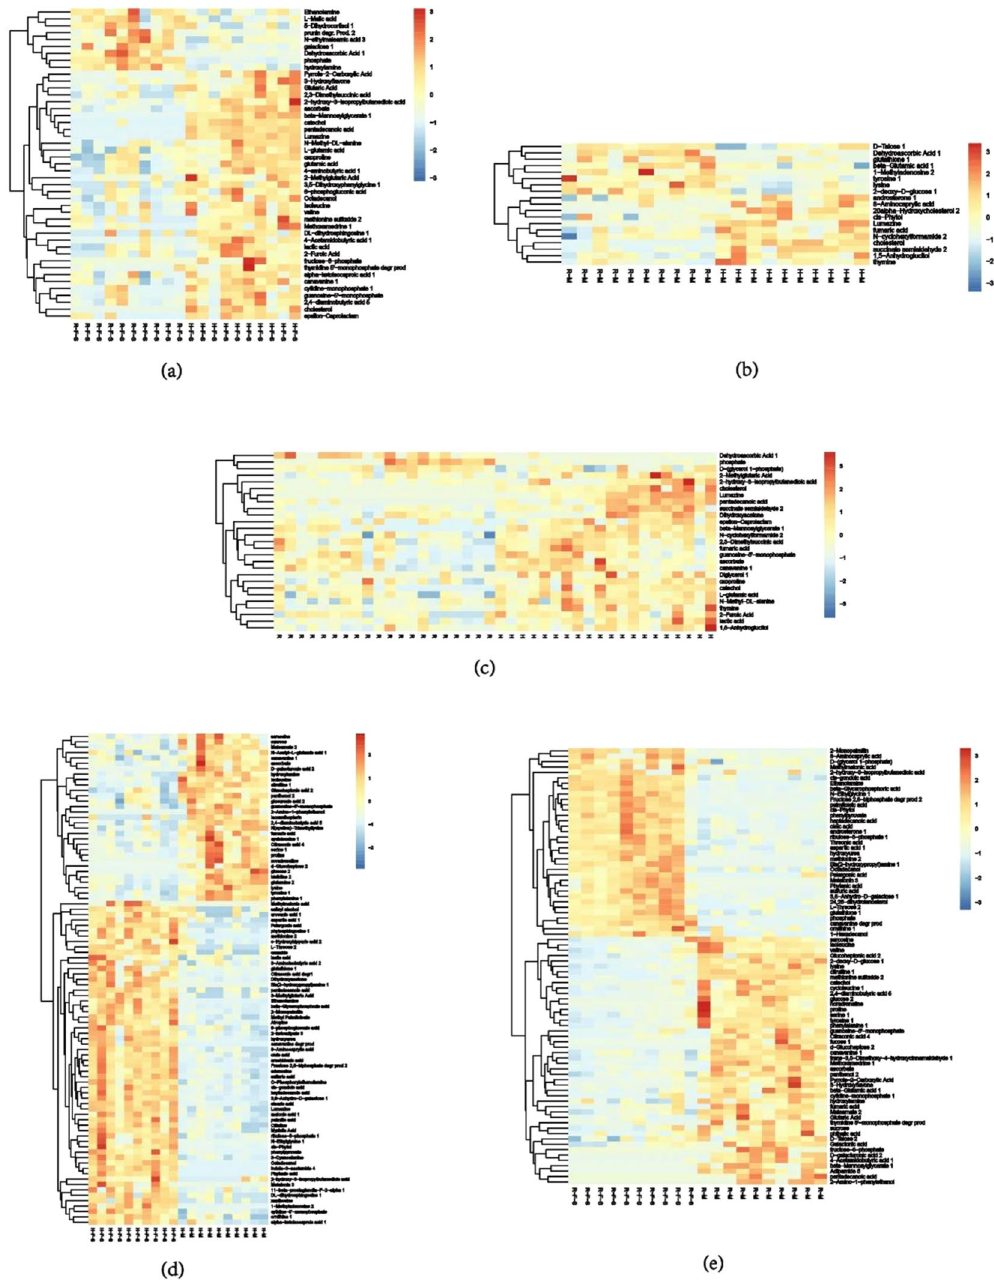
Figure 3. Heatmaps showing hierarchical clustering of metabolite profiles for different groups: ( a ) H-F-S and R-F-S, ( b ) H-M and R-M, ( c ) H and R, ( d ) H-F-S and H-M, and ( e ) R-F-S and R-M. Warm colors represent higher compound contents, whereas cool colors represent lower compound